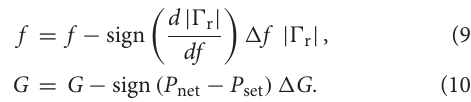
plotted by filled circles in Figure 5B and by open circles and filled squares in Figure 5C , respectively. The net power P net is simply calculated by P net P f – P r and plotted by crosses in = Figure 5C . The optical emission intensity shows that plasma can be produced for the frequency range of 39.5–42 MHz.